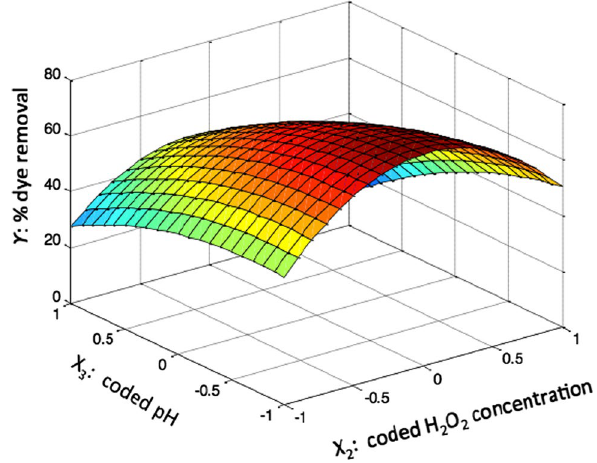
Fig. 7 Surface graph of dye removal showing interaction of H dosage and pH value